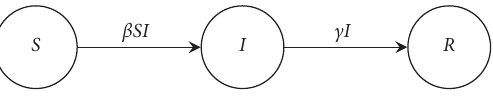
Figure 1: SIR model flow